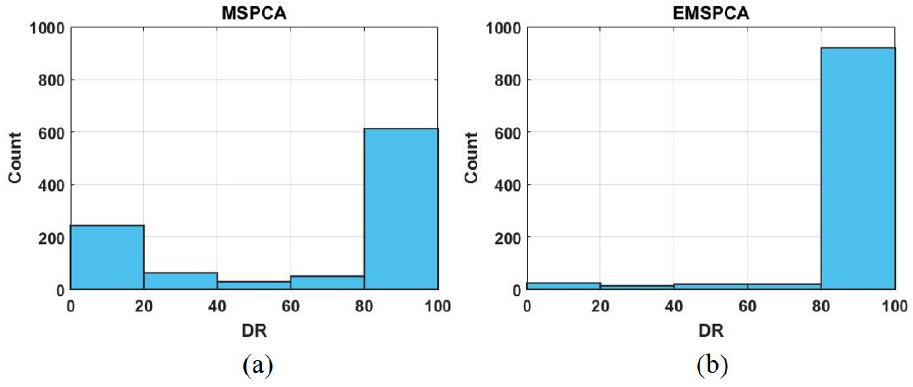
Figure 6. DR distributions for MSPCA ( a ) and EMSPCA ( b ); depth of 4, a fault magnitude of 1 sigma, 1000 MC